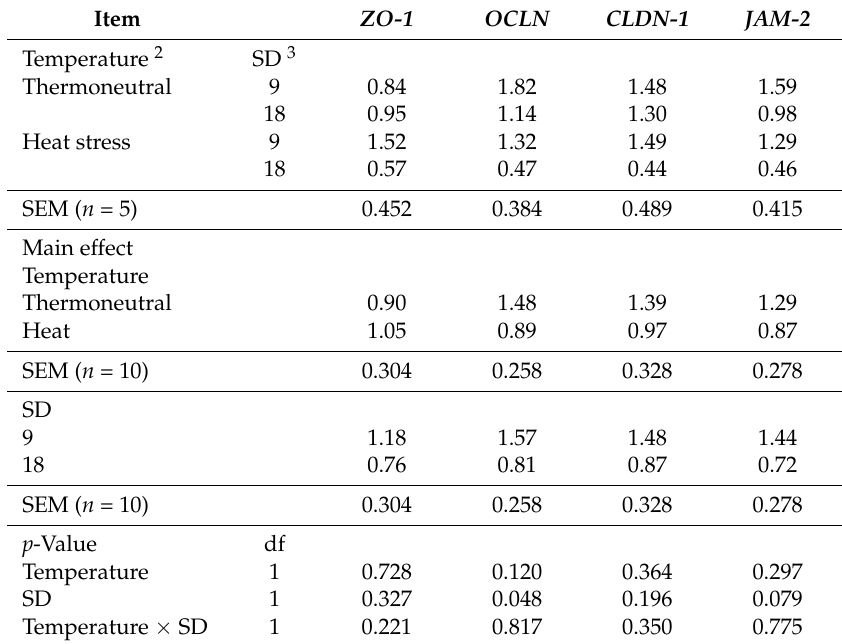
Table 5. Effect of heat stress and stocking density on tight junction-related gene expression 1 in the jejunal mucosa of growing broiler